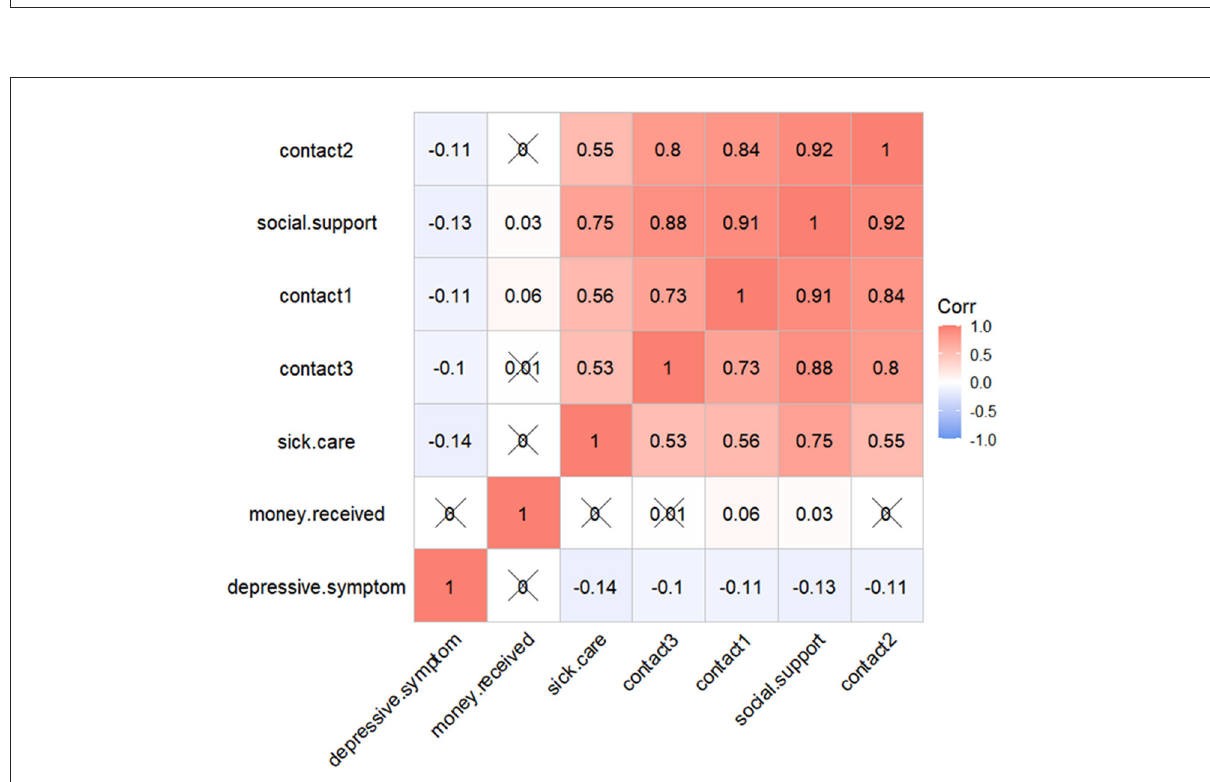
FIGURE2 Correlation coefficient of social support and depressive symptoms. × P >